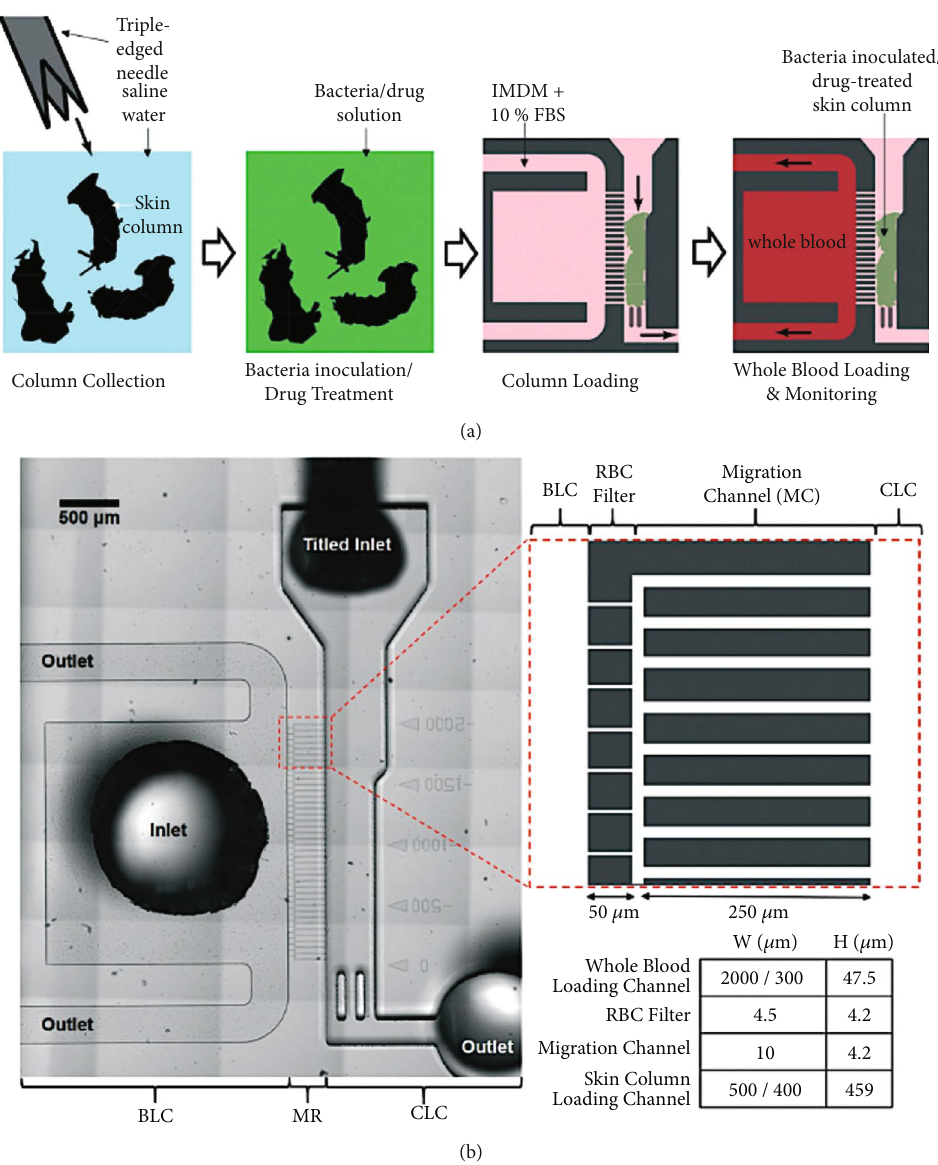
Figure 21: Ex vivo skin-on-a-chip assay for the diagnosis of skin and soft tissue infections. (a) Schematics of the human skin and blood sample loading. (b) Micro fl uidic design of ex vivo skin-on-a-chip. Left shows the bright fi eld image of ex vivo skin-on-a-chip. Top-right represents the design of the migration channel (MC). Bottom-right shows the dimension of ex vivo skin-on-a-chip components: whole blood loading channel (BLC), red blood cell (RBC) fi lter, MC, and skin column loading channel (CLC). Reproduced (or adapted) with permission [114], ©2018, Royal Society of